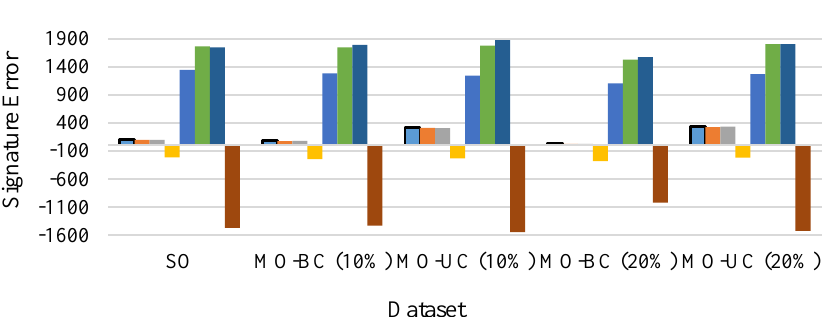
Figure 17. FHV (FDC) errors based on observations and simulations of five datasets using two main calibration approaches (SO & 4 algorithms parameterization of MO-SB).